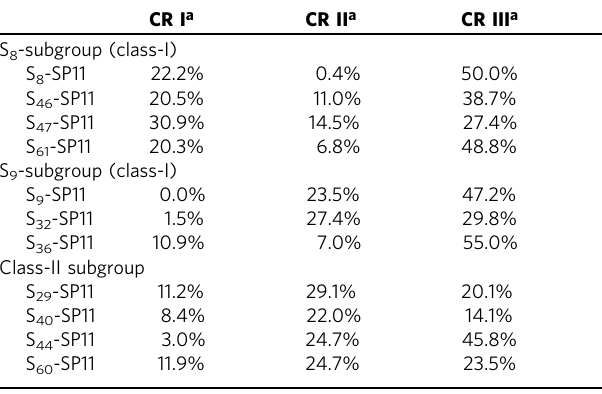
Table 1 Proportion of Δ G contribution from